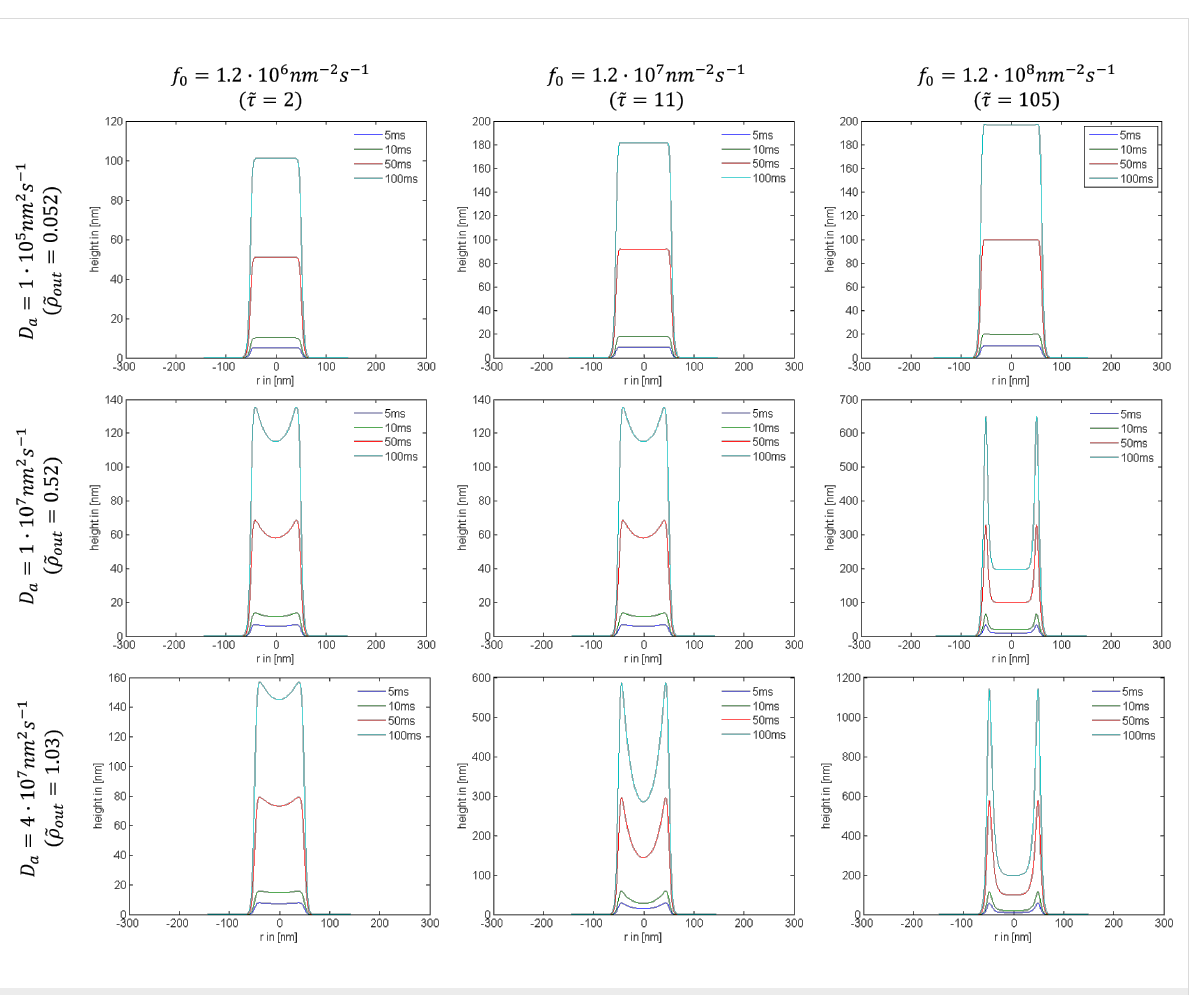
Figure 21: Examples of deposit geometries simulated using exposure times ( t ) of 5 ms; 10 ms; 50 ms; 100 ms, a tophat beam profile, and selected values of the maximum electron flux f 0 and surface diffusion coefficient D a ( s a = 1, F a = 10 4 nm − 2 s − 1 , n 0 = 2 nm − 2 , τ a = 100 μ s, σ a = 0.013 nm 2 , V a = 0.2 nm 3 and FWHM = 100